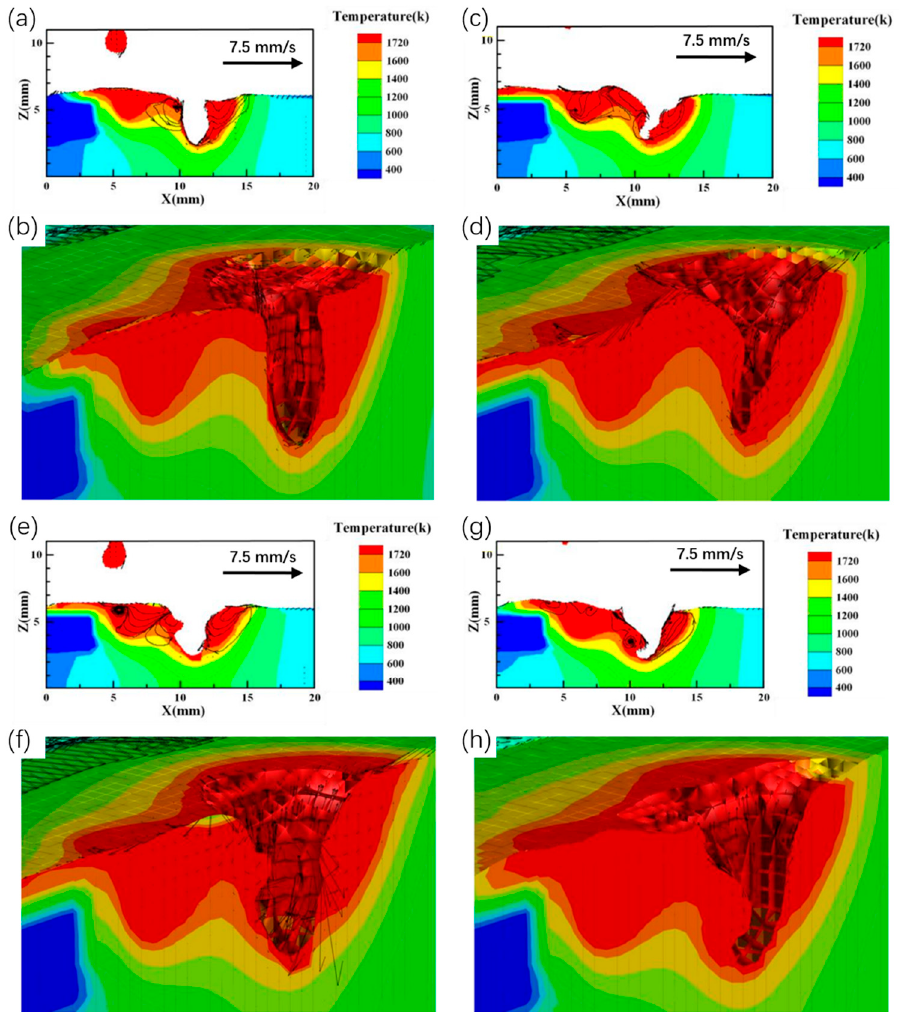
Figure 10. Temperature field distribution of the weld section and three-dimensional fluid flow diagram of the molten pool at different times: ( a , c , e , g ) are the temperature field of the weld section at 2700 steps, 3400 steps, 4000 steps, and 4880 steps, respectively; ( b , d , f , h ) are the three-dimensional fluid flow diagrams of the molten pool at 2700 steps, 3400 steps, 4000 steps, and 4880 steps, respectively.